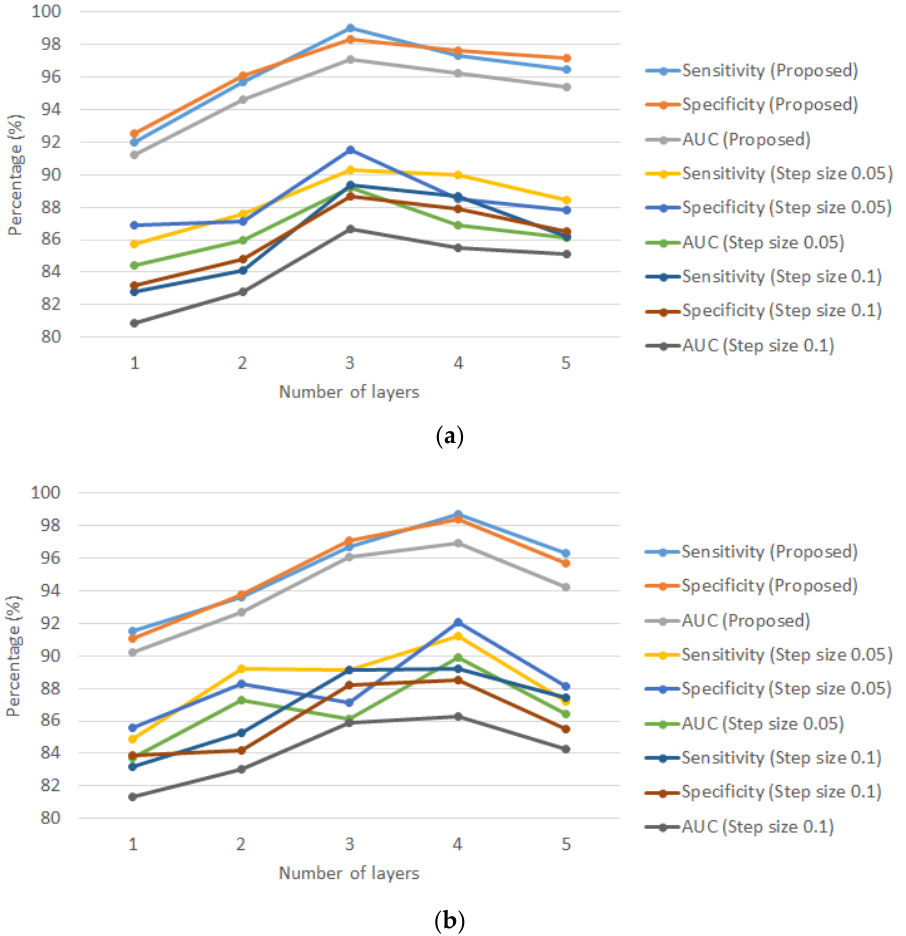
Figure 7. Average sensitivity, specificity and AUC of the proposed algorithm using MOGA and a traditional grid search with a step size of 0.05 and a step size of 0.1, versus the number of layers under a 10-fold cross-validation: ( a ) driver drowsiness recognition and ( b ) driver stress recognition.